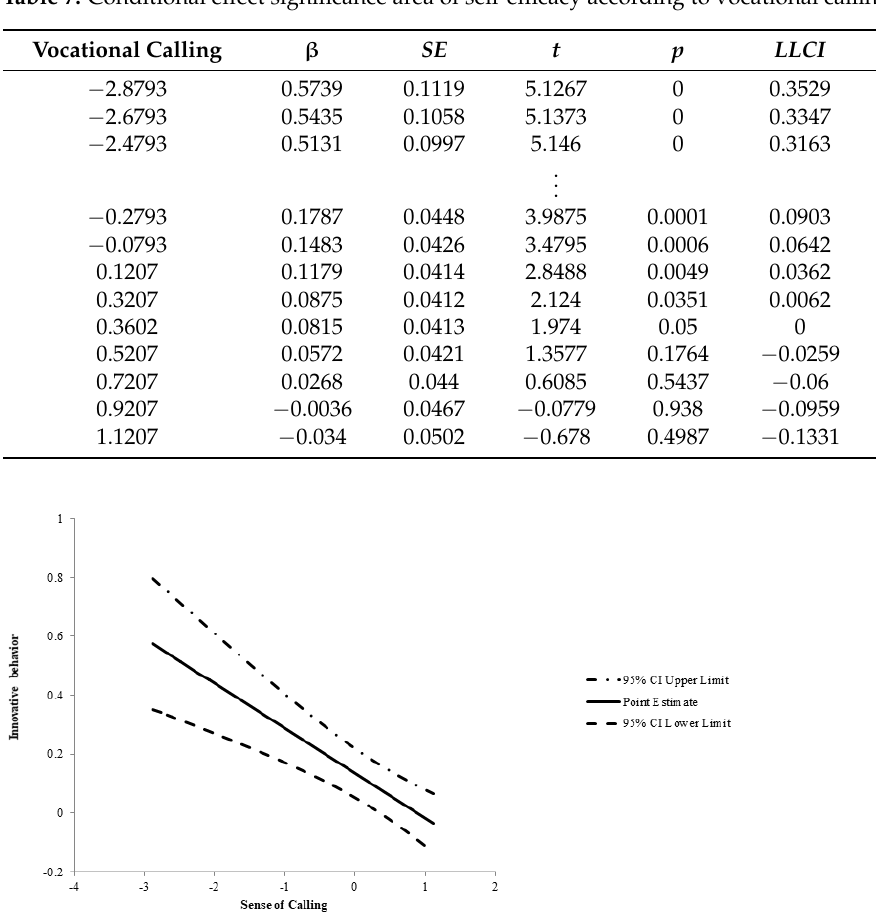
Figure 2. Conditional effect of servant leadership on self-efficacy at values of the moderator vocational calling.